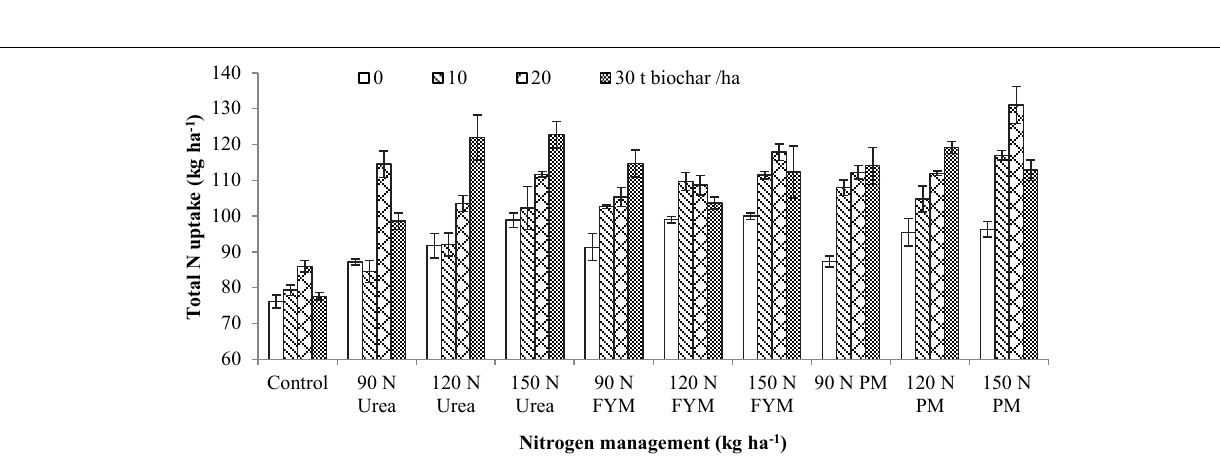
FIGURE 10 | Interactive effect of biochar and N levels applied from different sources on total nitrogen uptake by wheat. Bars on graph denote SE of mean ( n = 3). FYM, farmyard manure; PM, poultry manure.